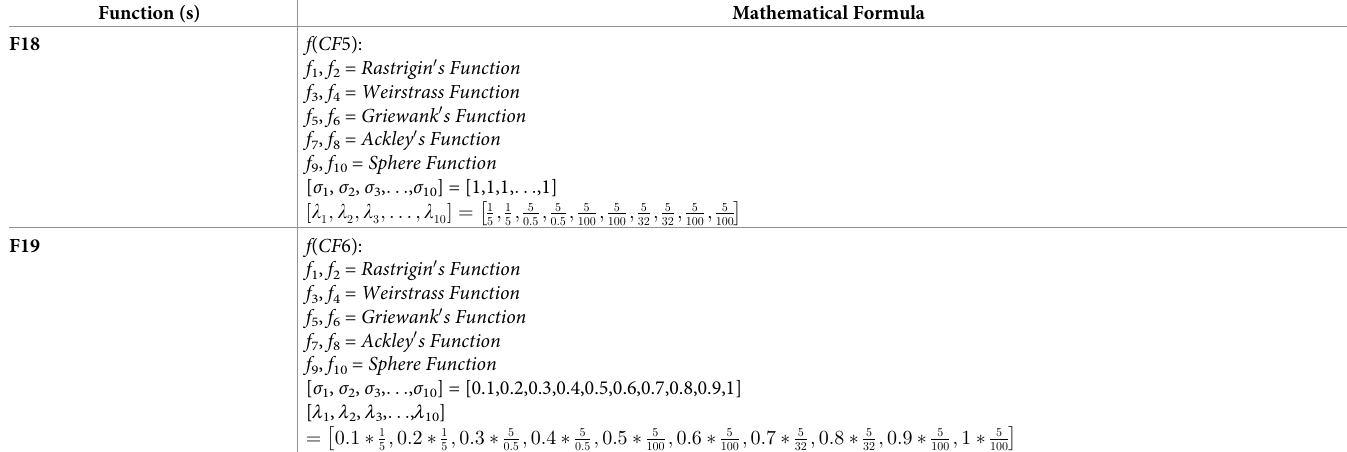
by BOA for F04, HS for F05, and DE for F06. Overall, it can be seen that MSCA has high searching precision on unimodal and multimodal problems. Despite the complexity they offer during search by composite functions, MSCA performed better. The CSA was found to be the most unstable algorithm in the above batch and was not able to perform on multimodal or composite functions. The mean convergence performance of all the algorithms can be seen in the Figs 6 and 7. For standard deviation (SD), MSCA is able to perform with best SD values on F01-F03,